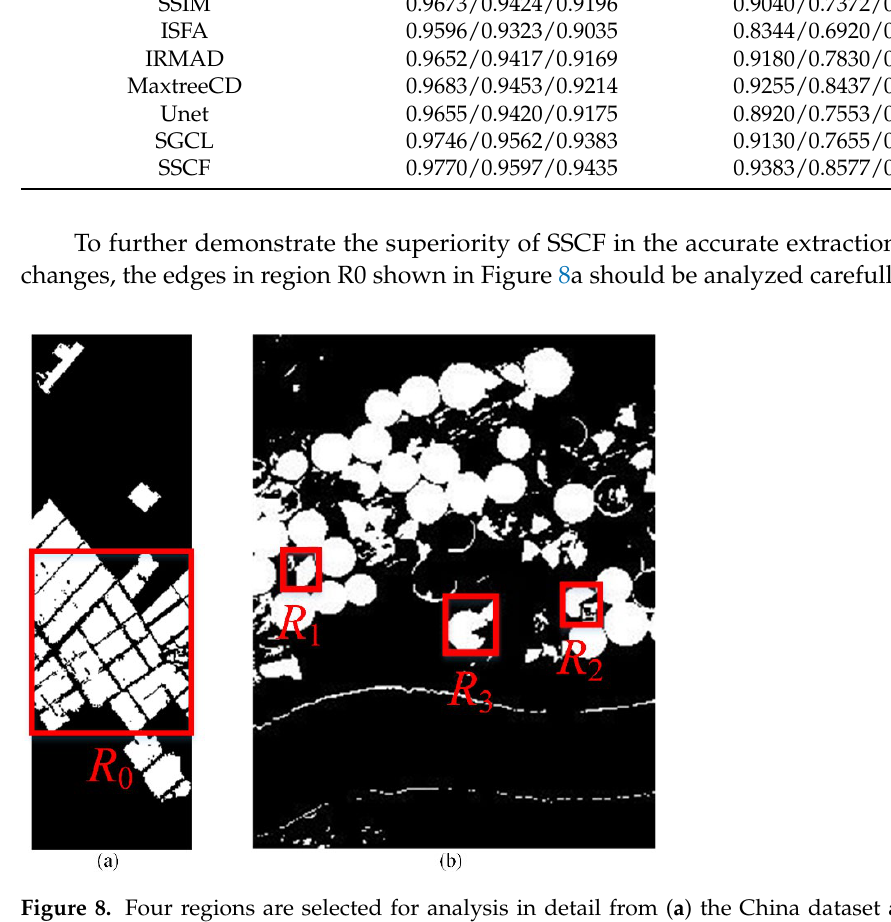
Figure 9. Binary CM of the China dataset using different methods: ( a ) CVA, ( b ) SSIM, ( c ) ISFA, ( d ) IRMAD, ( e ) MaxtreeCD, ( f ) Unet, ( g ) SGCL, ( h ) SSCF, ( i ) Ground-truth.